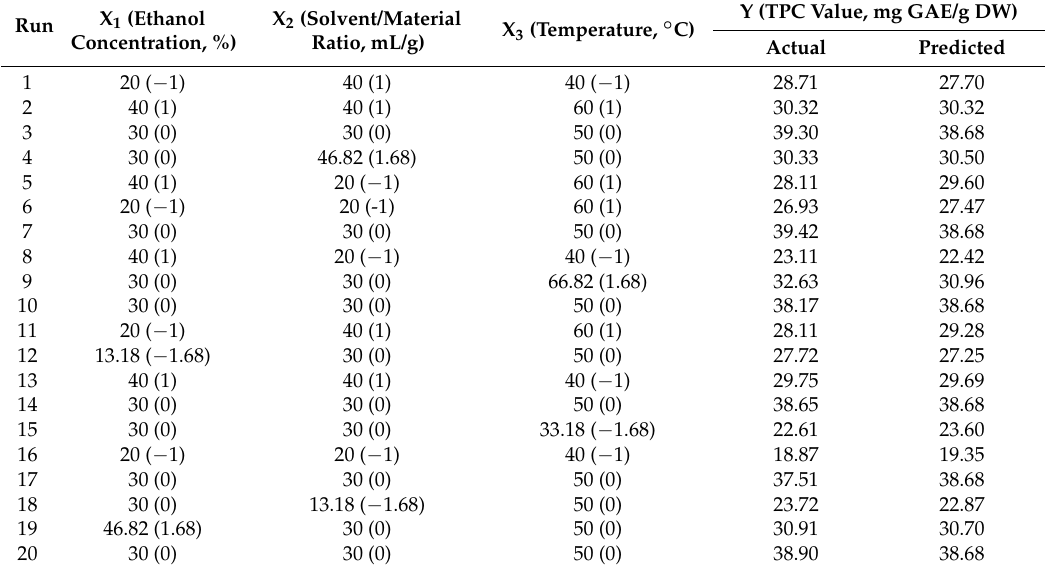
Table 1. The central composite design, coded and actual levels of three independent variables, actual and predicted values of total phenolic